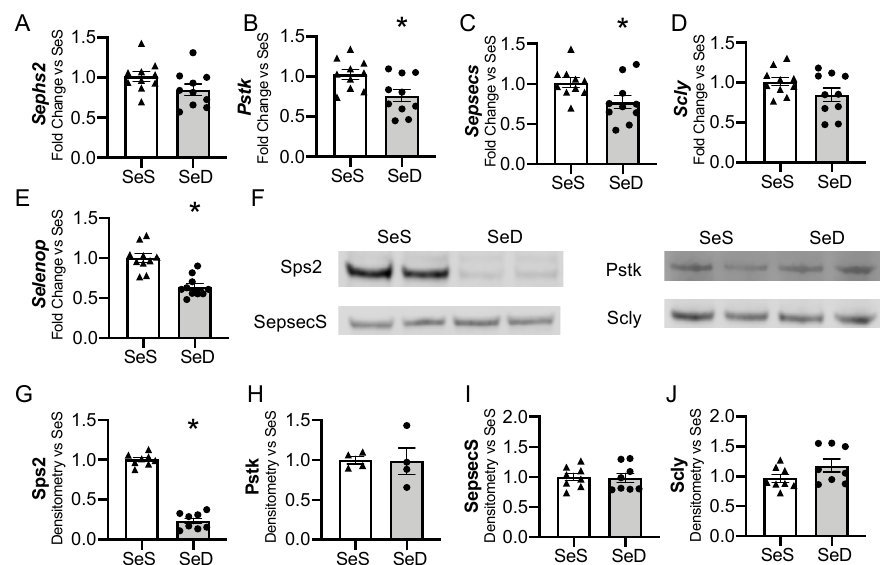
Figure 3. Hepatic factors for selenocysteine synthesis and Se transport in neonates born after antenatal Se deficiency. C57Bl/6 mice were placed on diets that differed only in Se content, either 0.4 ppm or <0.01 ppm of sodium selenite. Breeding was initiated after 2–4 weeks on diet and natural delivery was allowed. Hepatic organ homogenate was evaluated on day of birth. Each data point represents either a female or male from each litter; each individual point is an average of two mice. Fold change in ( A ) Sephs2 , ( B ) Pstk, ( C ) Sepsecs mRNA, ( D ) Scly mRNA, and ( E ) Selenop mRNA are shown normalized to SeS samples. ( F ) Representative Western blots of hepatic Sps2, Pstk, SepsecS, and Scly. Densitometric analysis of ( G ) Sephs2, ( H ) Pstk, ( I ) SepsecS, and ( J ) Scly protein content expression. Results are normalized to total protein stain and expressed as a ratio to SeS mice. N = 4–10 for all groups. Data and presented as mean (±SEM), * p < 0.05 vs. SeS control, by two-sided t-test.